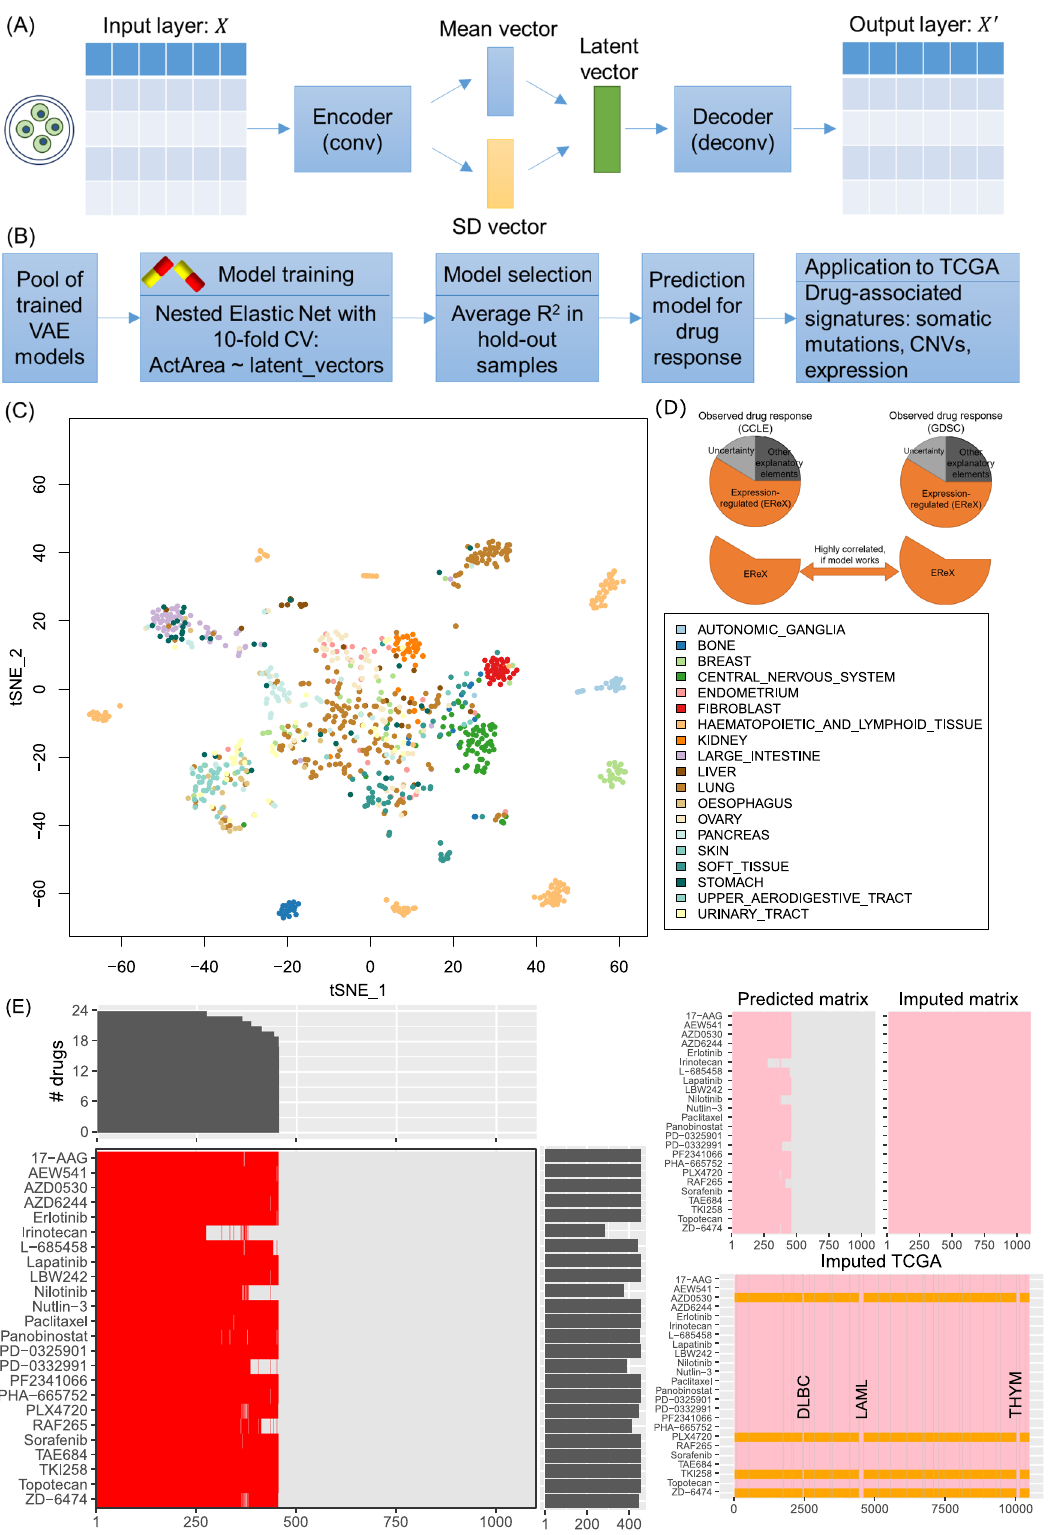
model) using tenfold cross-validation by a standard multivariate linear regression. The average coef fi cient of determination R 2 in the holdout samples was used to measure the model ef fi ciency. Among the 100 VAE models (i.e., 100 latent matrices), the one with the highest average holdout R 2 was selected for each drug in the following